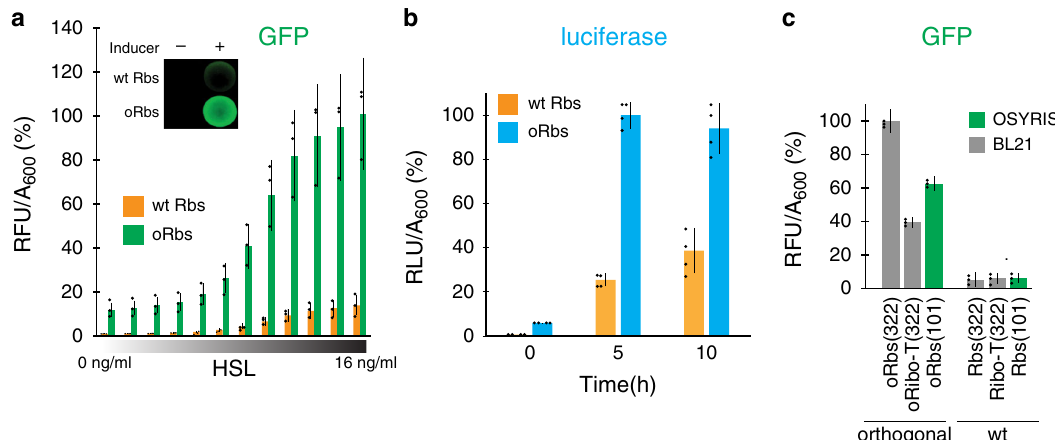
Fig. 3 Expression of the orthogonal reporter in the OSYRIS cells. a, b Expression of o-reporters GFP ( a ) or luciferase ( b ) in OSYRIS cells carrying dissociable ribosomes with wt (wt Rbs) or orthogonal (oRbs) 30S subunit. Transcription of o- gfp was induced by varying concentrations of the inducer, homoserine lactone (HSL) 38 . Transcription of o- luc was induced by 1 ng/ml of HSL. The inset in ( a ) shows the UV light picture of the agar plate onto which the indicated cells were spotted and grown. c Comparison of the expression of the o- gfp reporter in OSYRIS cells expressing oRbs from a low copy number plasmid (green bars) with that in BL21 cells expressing oRbs or oRibo-T from a medium copy number plasmid (gray bars) (see Supplementary Fig. 1a, b). The medium-copy number plasmids are based on the pBR322 replication origin (322); the low-copy number plasmid is based on pSC101 replication origin (101). The graph bars represent the mean ± s.d. of 3 ( a , c ) or 4 ( b ) biological replicates. The raw data can be found in the Source data fi le.